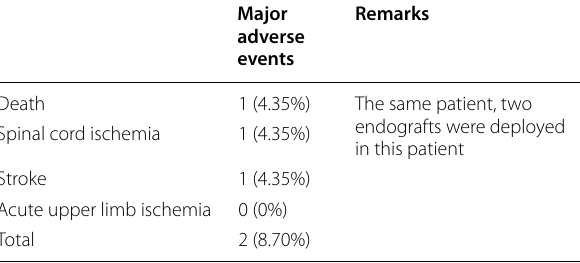
Table 3 Major adverse